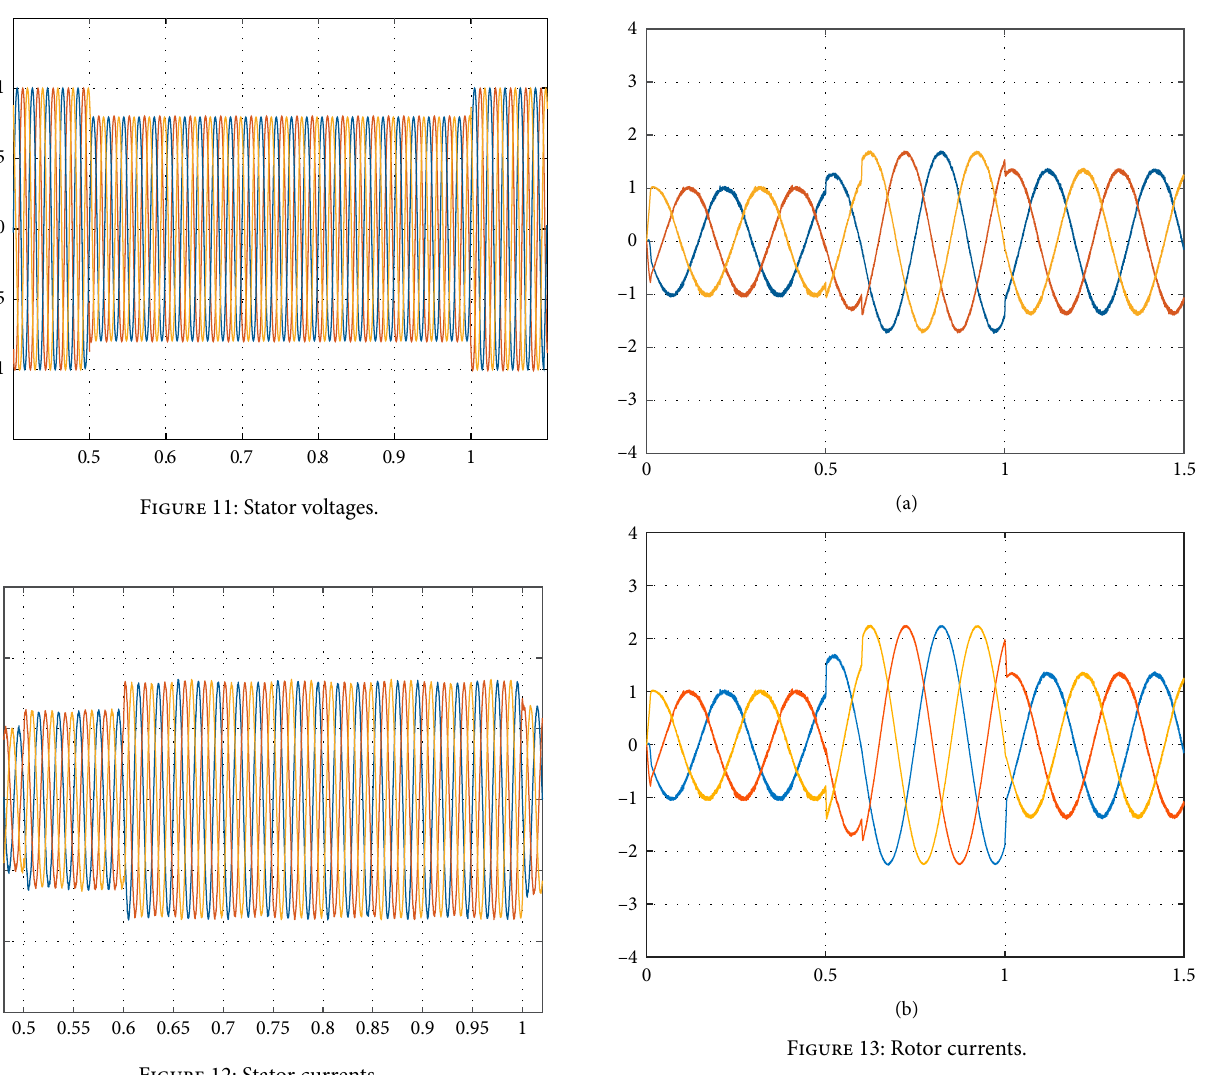
Figure 12: Stator currents.